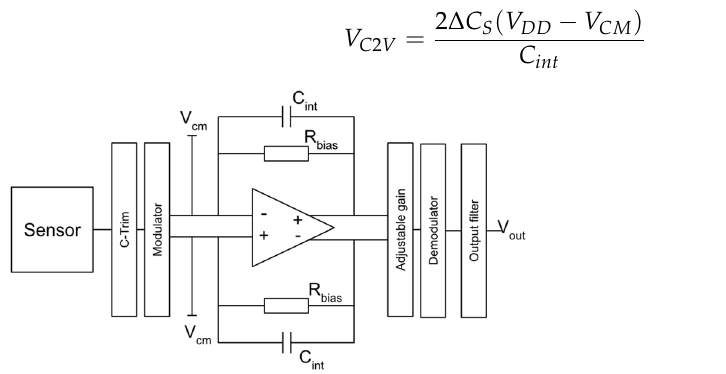
Figure 2. Block diagram of capacitance-to-voltage converter circuit implemented with both MEMS devices.